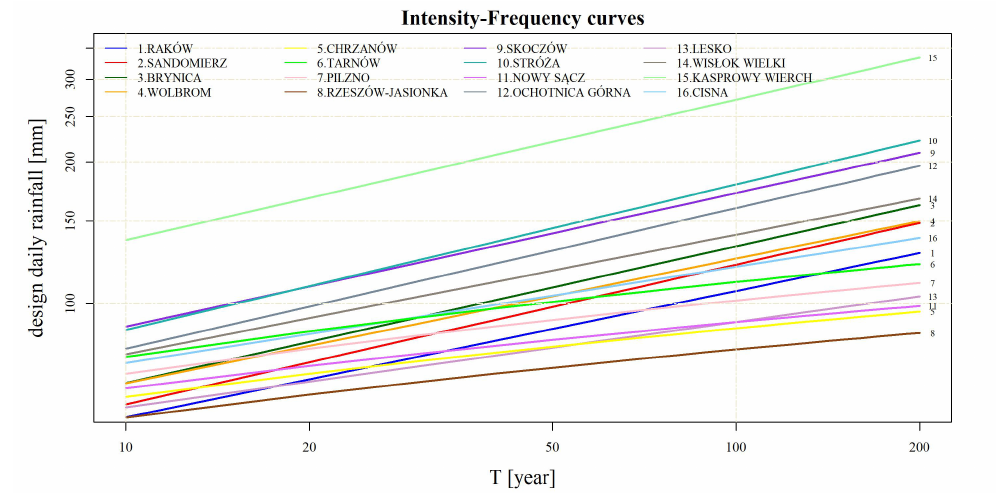
Figure 6. IF curves for various return periods T , logarithmic